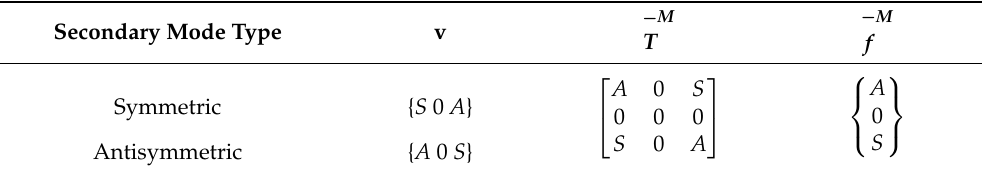
Table 1. The symmetries of velocity and nonlinear forcing terms for different secondary modes from the symmetric–antisymmetric mode mutual interaction.